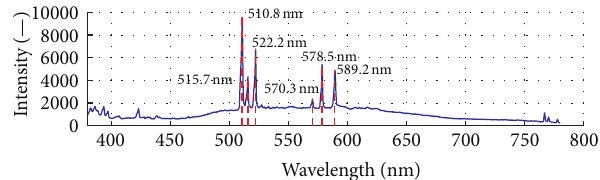
Figure 6: Spectral distribution depicting dominant components within the VIS range.